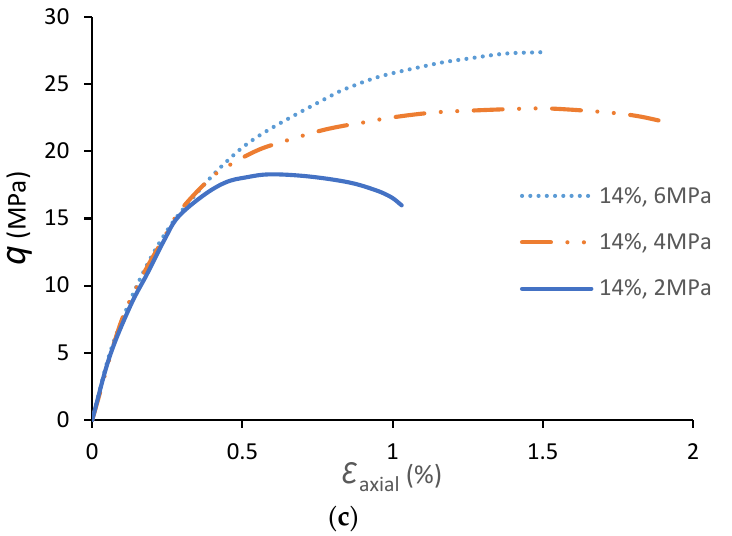
Triaxial tests were conducted on TWHC specimens with 15 mm diameter borehole for three different cement contents (10%, 12%, and 14%) and various confining pressures. Figure 7 p resents the deviatoric stress (σ deviatoric = σ 1 − σ hydrostatic ) versus the axial strain dia- gram for TWHC specimens with cement contents between 10% and 14%.